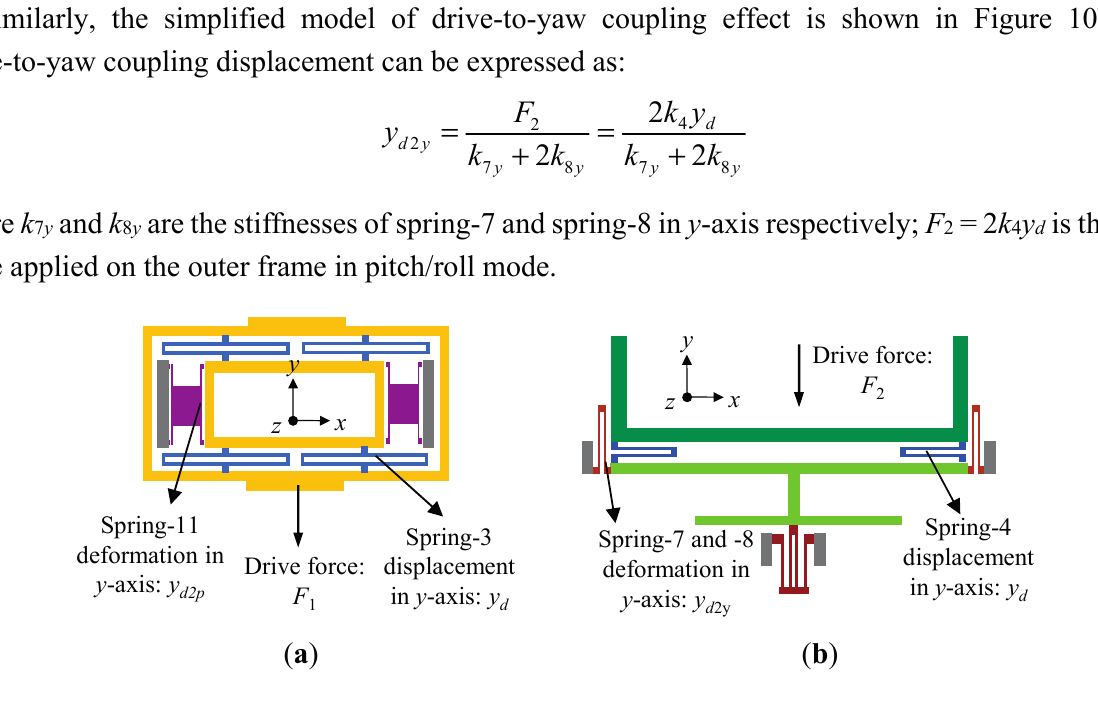
Figure 10. Simplified models of drive-to-sense coupling effect: ( a ) Drive-to-pitch coupling effect; ( b ) Drive-to-yaw coupling effect.